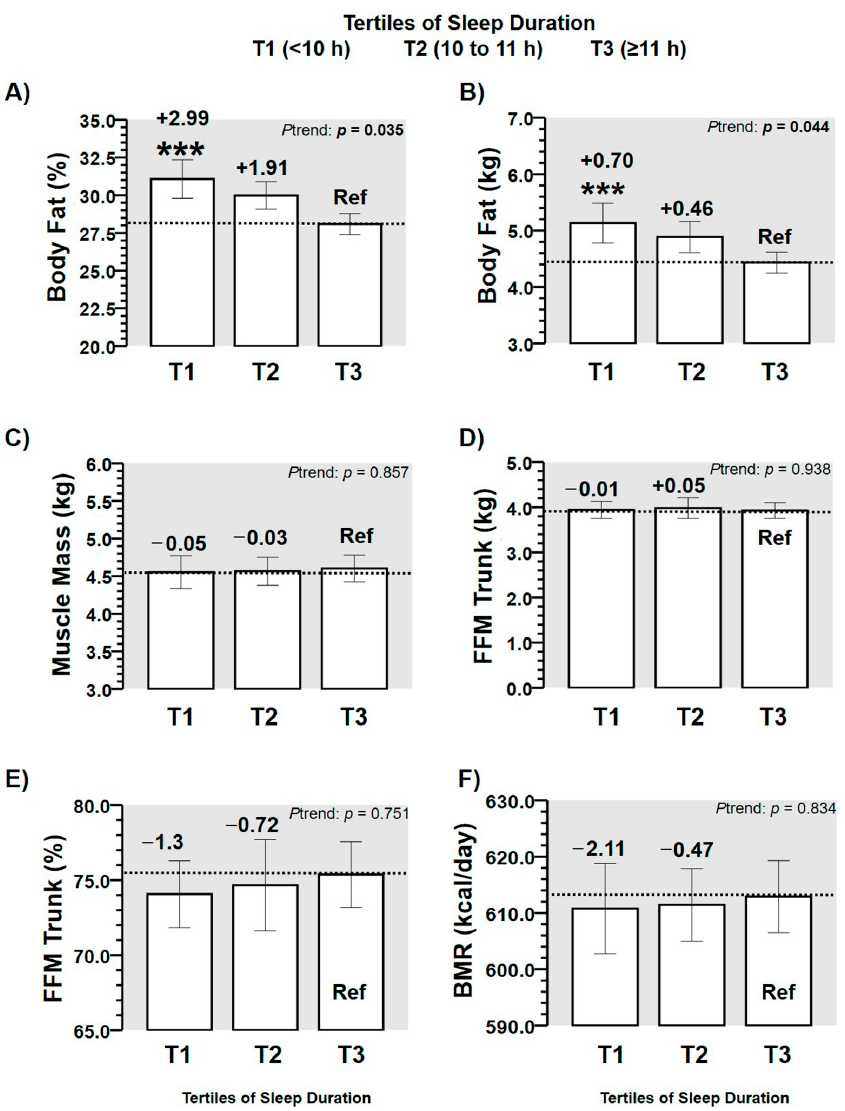
Figure 3. Characteristics of body composition outcomes in a sample of preschoolers ( n = 99) by tertiles of sleep duration, described as tertile 1 (T1: < 10 h of sleep time; tertile 2, T2: 10 to 11 h of sleep duration; tertile 3, T3: ≥ 11 h of sleep duration, that was used as the Reference category). (FFM) Fat free mass of trunk) Fat-free mass of trunk in kg or %, (BMR) Basal metabolic rate in kcal/day. Panel ( A ) describe body fat in percentage, ( B ) body fat in kilograms, ( C ) muscle mass, ( D ) fat free mass of trunk in kilograms, ( E ) fat free mass of trunk in percentage, and ( F ) basal metabolic rate, across tertiles of sleep duration. (***) Denotes significant differences between tertile of origin vs. tertile Reference at p < 0.0001.